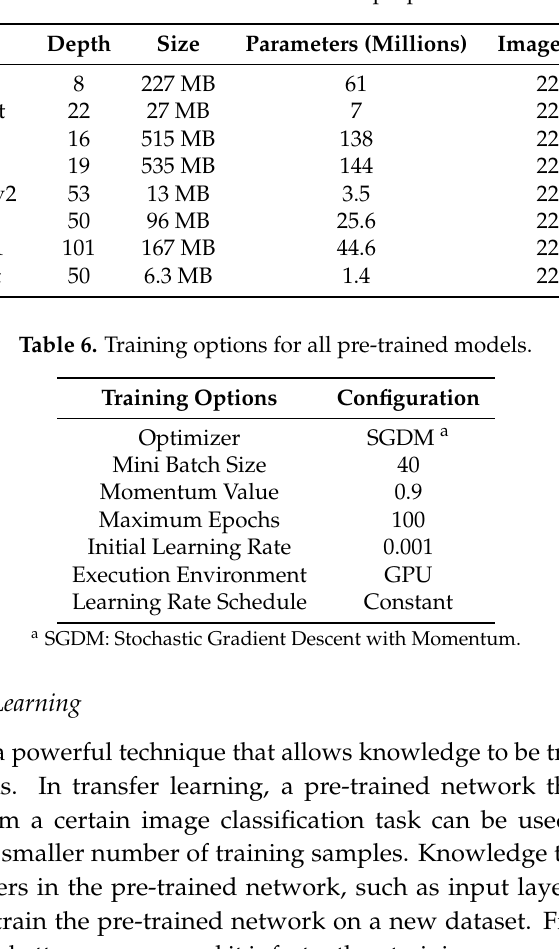
Table 5. Pre-trained networks properties.